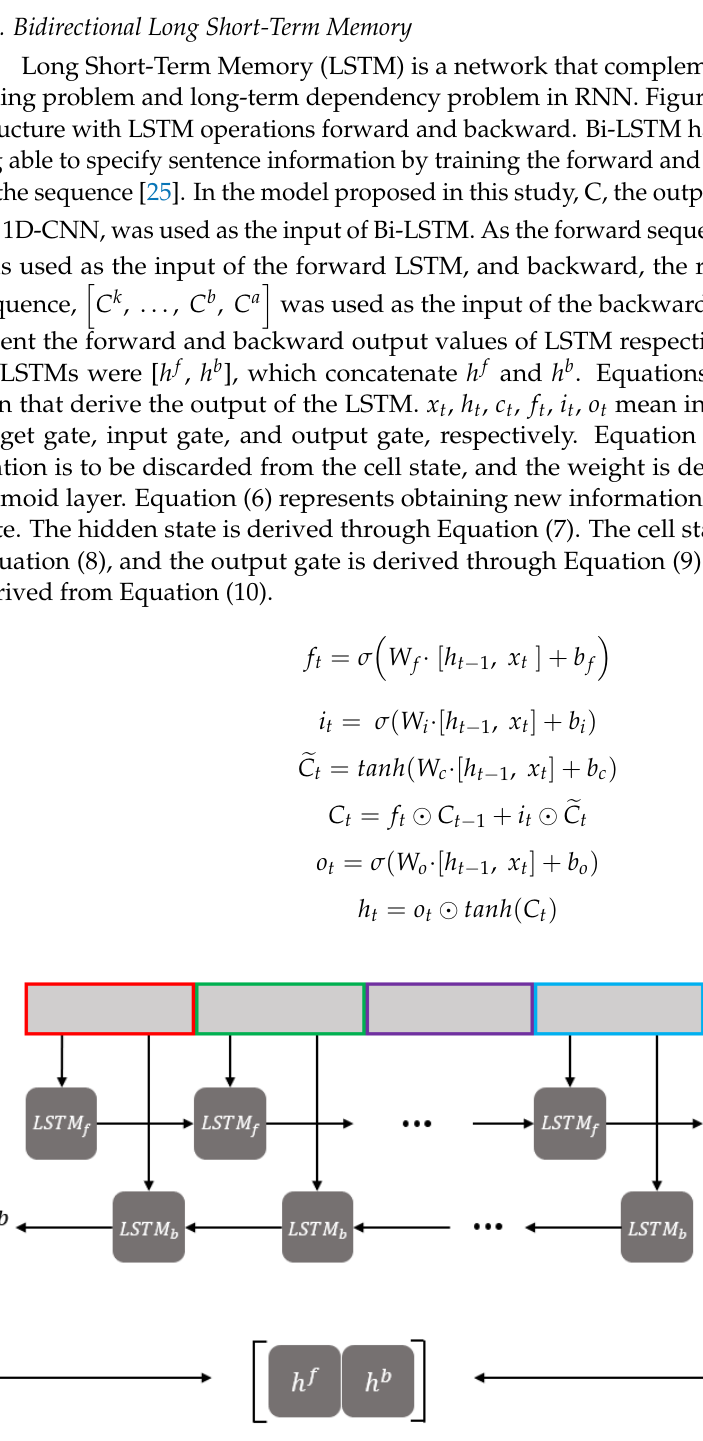
Figure 4. Bidirectional long short-term memory.